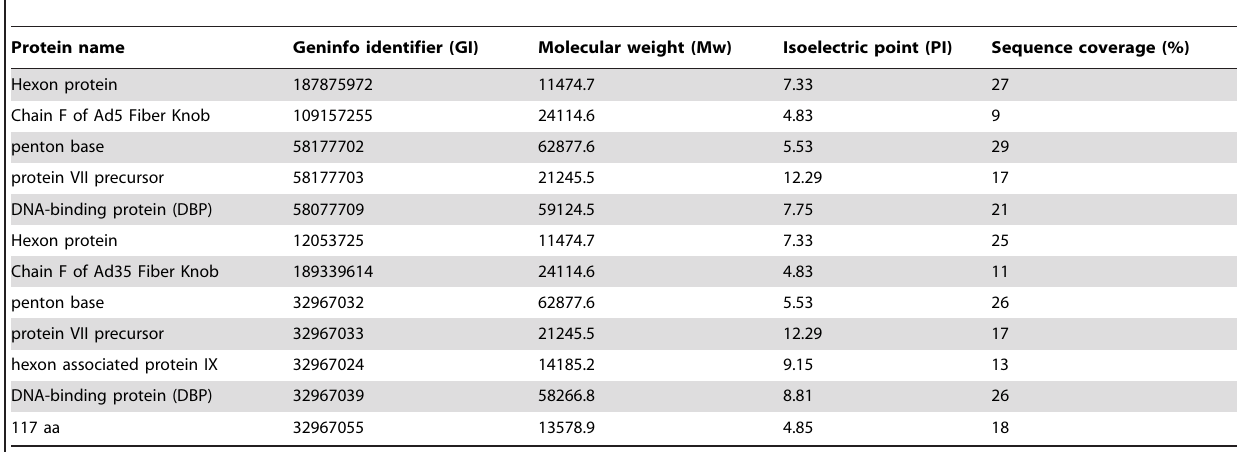
Table 1. Differentially expressed proteins in Ad5 (a) and Ad35 (b) infected HEK293 cells identified by MALDI-TOF/TOF after 2DE- PAGE and Western blot analysis.